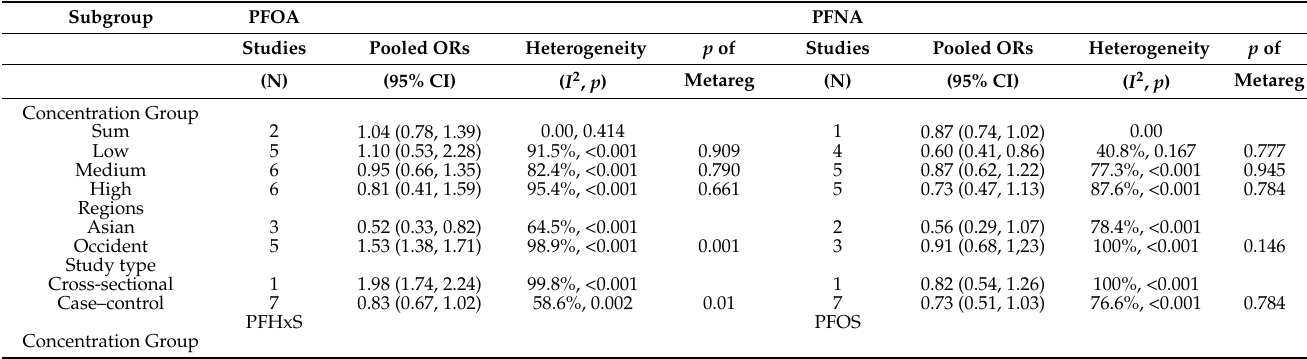
Table 3. Subgroup analysis and metaregression of